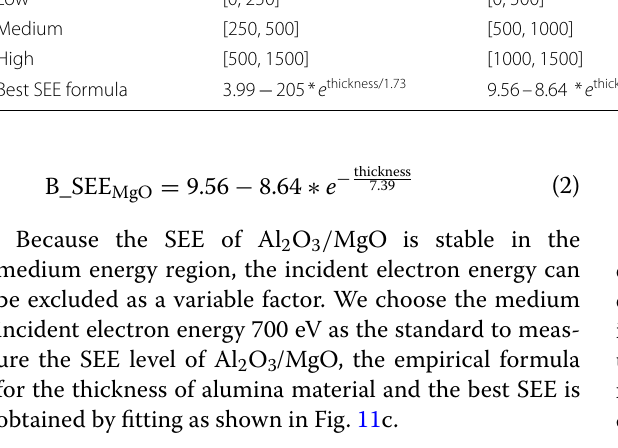
Table 1 Incident electron energy partition of different materials, and the empirical formula for the best SEE and thickness of the material Incident electron energy